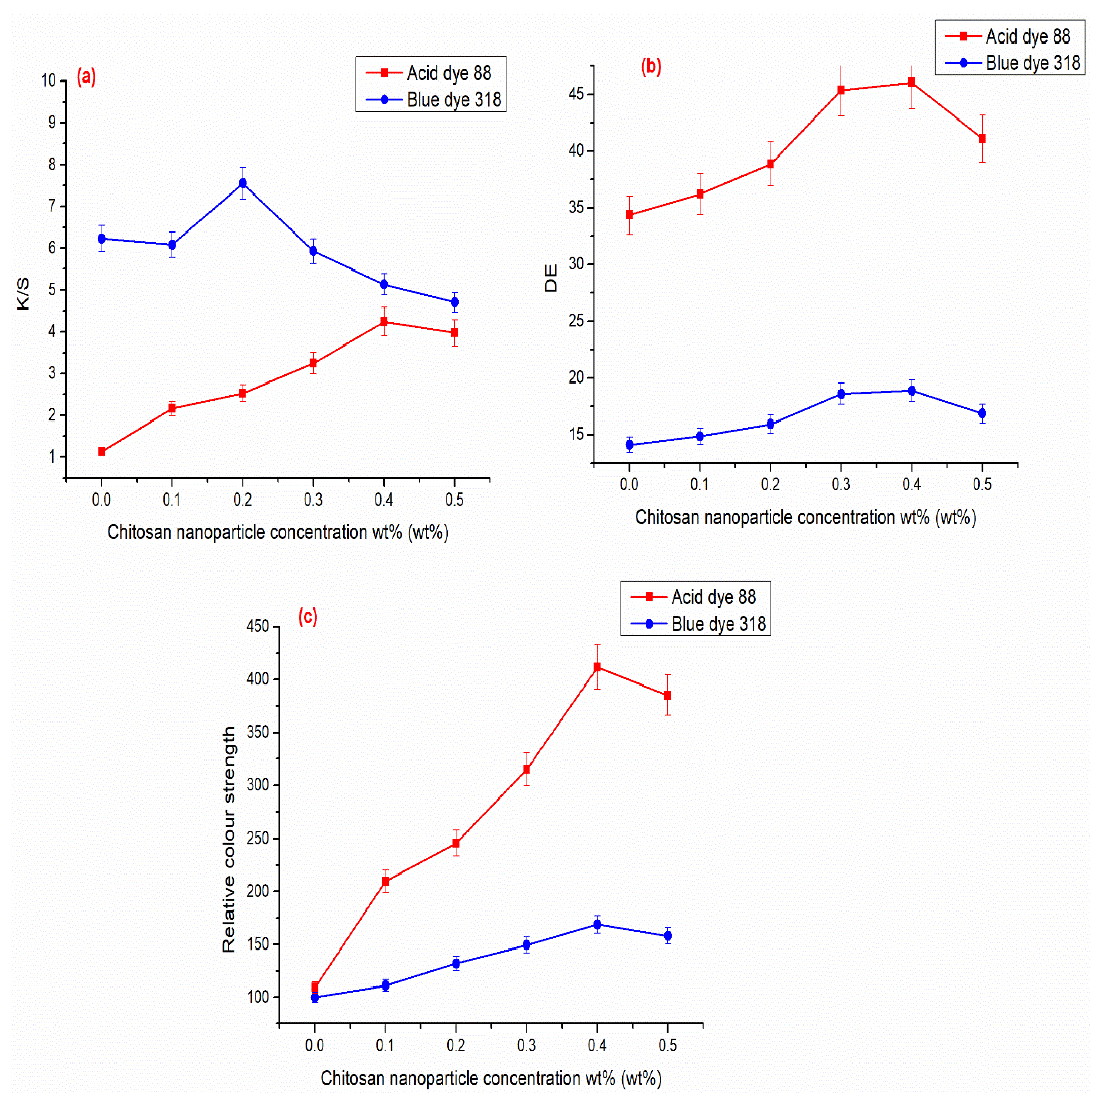
Figure 8. Effect of chitosan nanoparticles on the colour strength of Acid Red 88 and Acid Blue 318